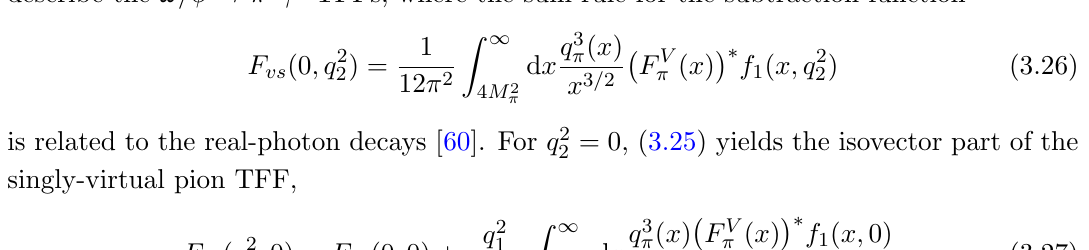
with q (cid:25) ( s ) = s= 4